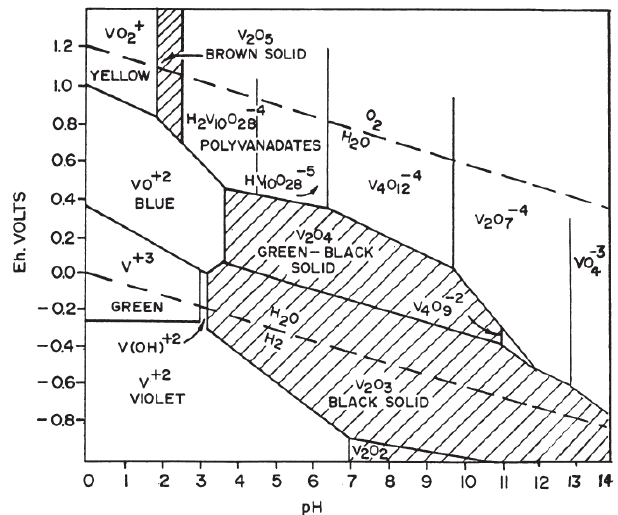
Figure 7. Relationship between the state of vanadium in aqueous solution and vanadium concen- tration and pH [30].